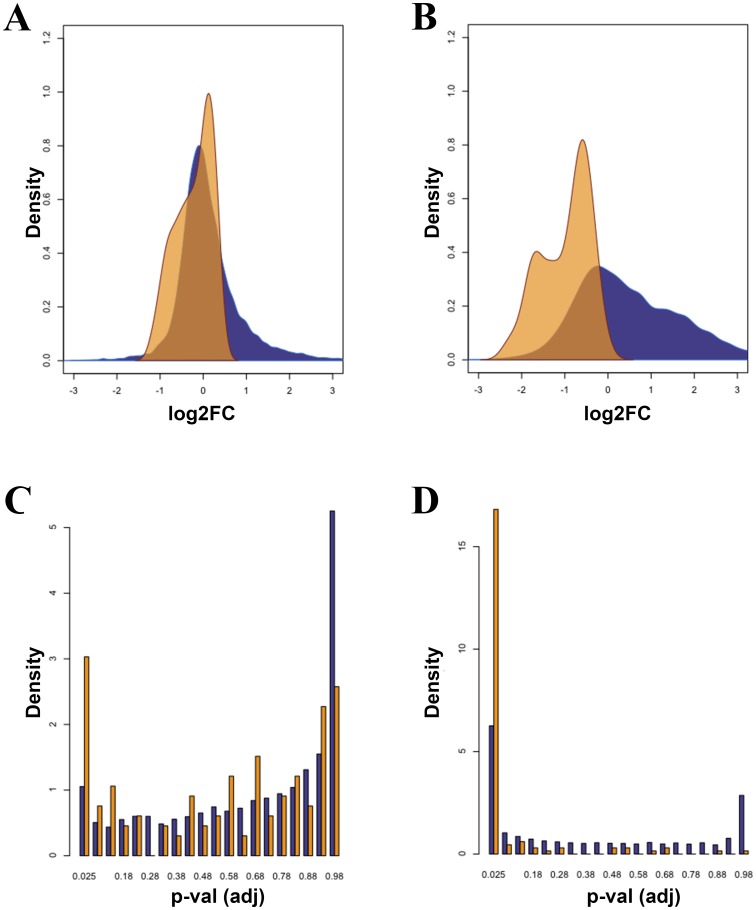
Genes encoding for proteins regulating Ribosome Biogenesis are negatively affected by viral infection.(A) and (B) Distribution of log ratios/fold-change (FC) in expression levels for all genes (blue) and genes encoding for nucleolar proteins involved in the ribosome biogenesis (orange) using Kernel density estimation; (A) samples sequenced in this study; (B) samples obtained from CHDT dataset, 24hs post infection. (C) and (D) Distribution of p-values, adjusted for multiple testing, for all genes (blue) or genes involved in the biogenesis of the nucleolus (orange); (C) this study, (D) from CHDT dataset.